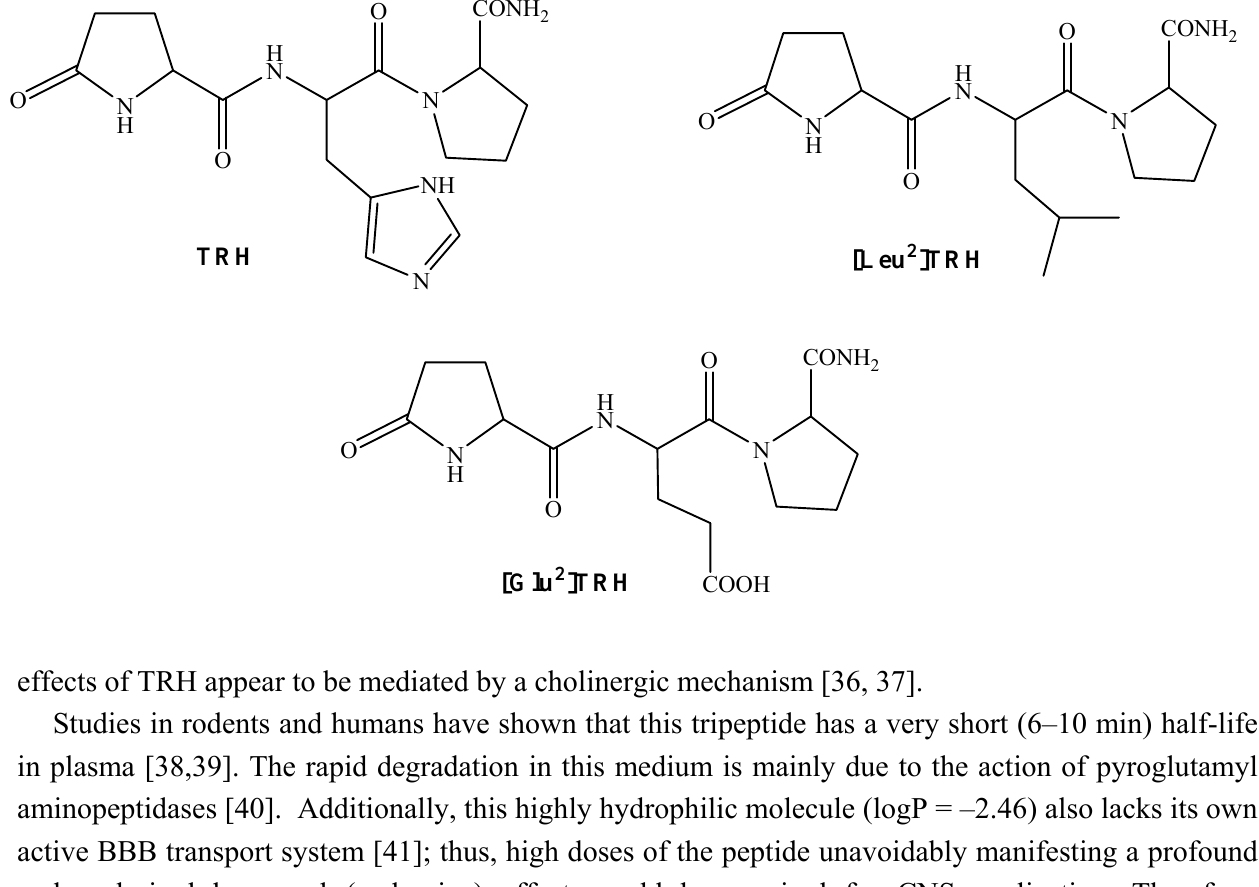
Figure 1 . Chemical structure of TRH and its analogues used in our